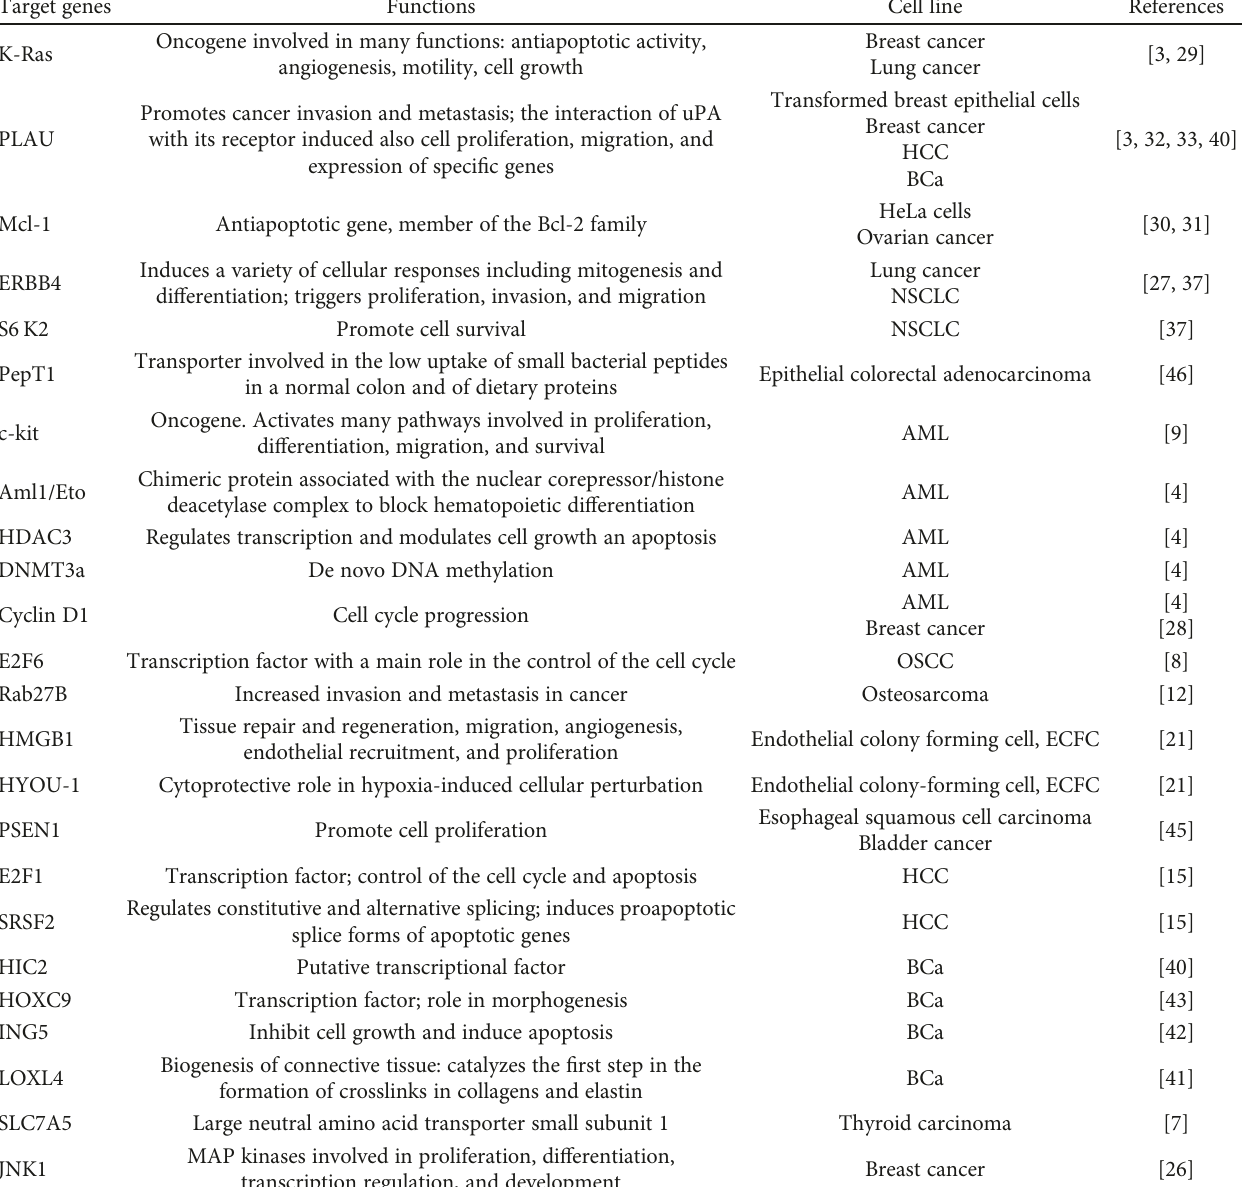
Table 2: miR-193a-3p gene targets validated